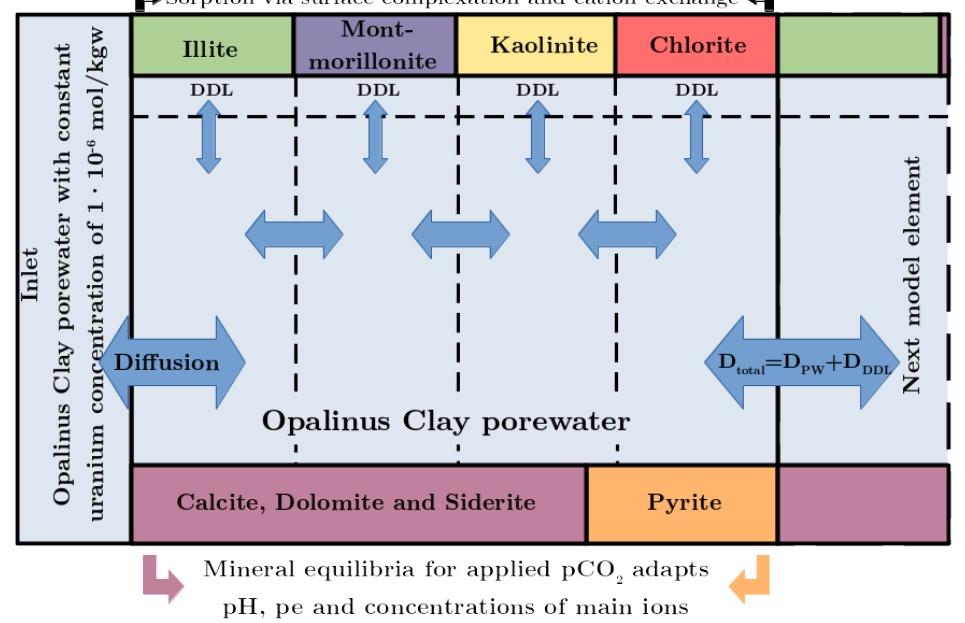
Figure 1. Concept of the one-dimensional finite-difference diffusion model in